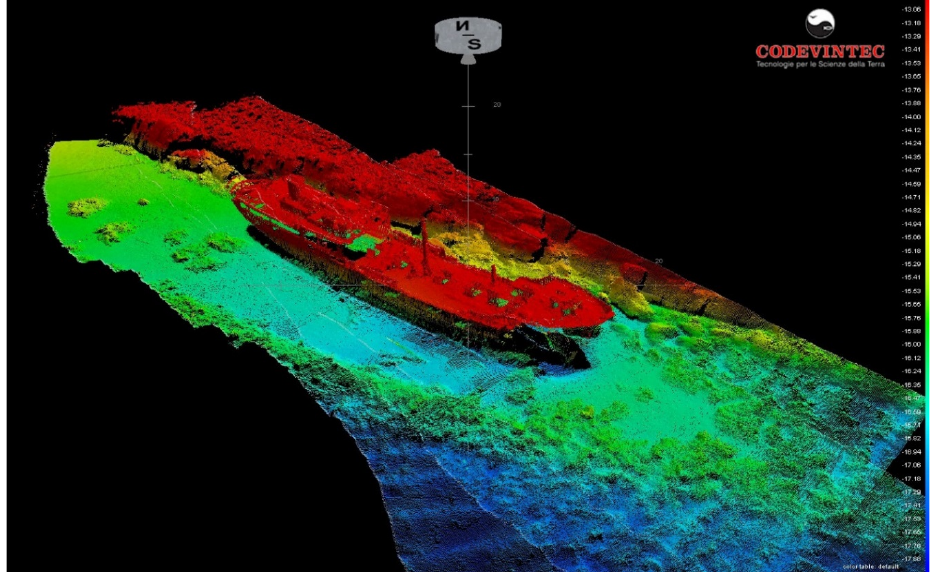
Figure 3: Visualization of the sonar measurements of Elphis I